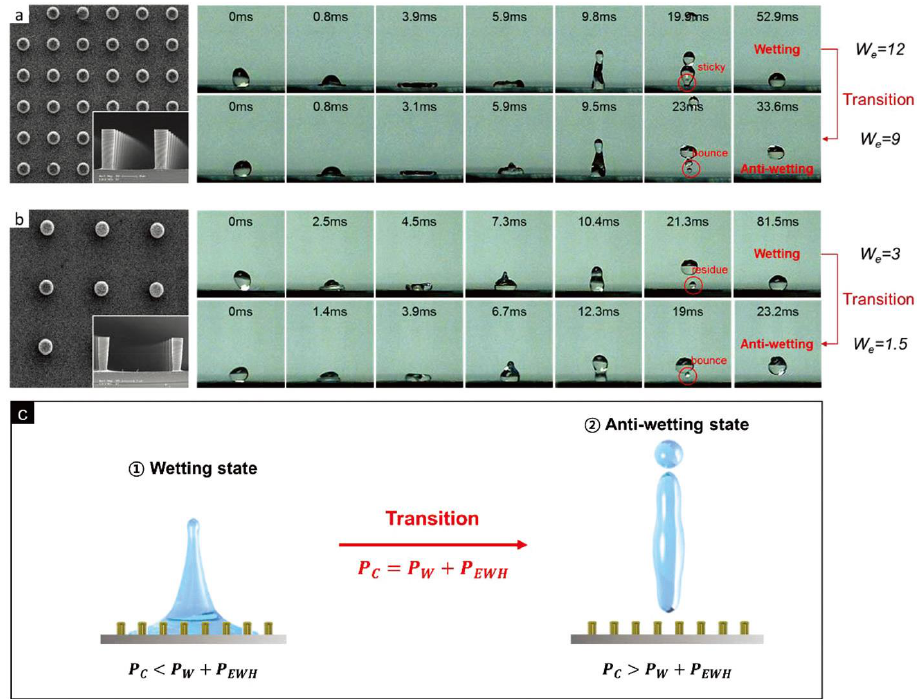
Figure 14. Snapshots of the impact dynamics of water droplets showing the transition between wetting/anti-wetting states at a critical We number: ( a ) ZnO/Si HNs with 50 μm spacing distance, showing a transition from the wetting state to the anti-wetting state at We = 9; ( b ) ZnO/Si HNs with 100 μm spacing distance, showing a transition from the wetting state to the anti-wetting state at We = 1.5; and ( c ) Schematic representation describing the transition from the wetting state to the anti-wetting state. (Adapted from [136] with permission; Copyright 2017 RSC).